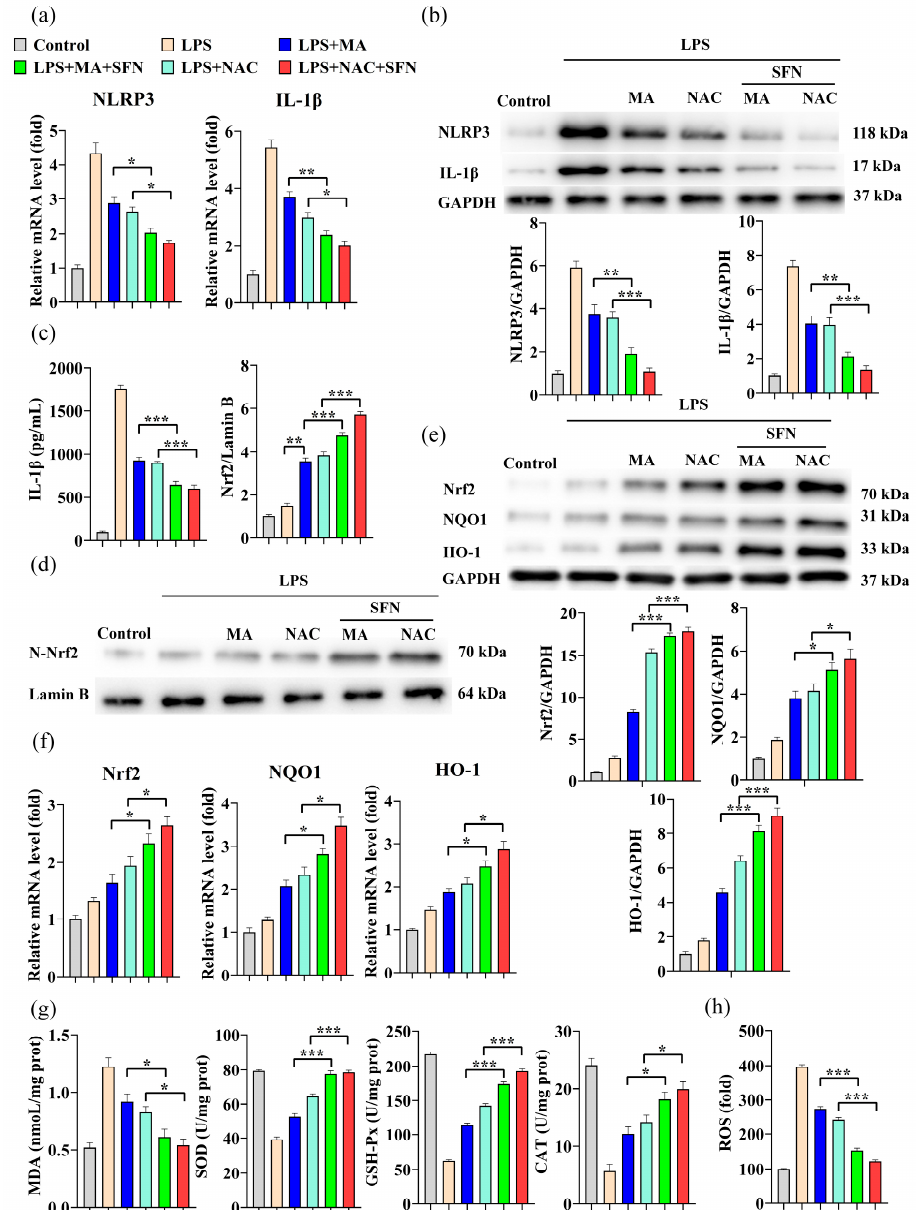
Figure 4. MA attenuates the inflammatory effects induced by LPS through the NLRP3/IL-1 β signaling pathway by activating the Nrf2 antioxidant pathway. Cells were pretreated with10 µ M SFN for 1 h and/or 100 mg/L MA for 12 h and/or 10 µ M NAC (Positive control) for 30 min and then stimulated with LPS (1mg/L) for 24h. ( a ) qRT-PCR was performed to evaluate the mRNA expression of NLRP3 and IL-1 β in RAW264.7 cells. ( b ) Western blot was performed to detect the protein levels of NLRP3 and IL-1 β in RAW264.7 cells. ( c ) ELISA was conducted to detect the levels of inflammatory cytokines IL-1 β in RAW264.7 cells. ( d ) Western blot was performed to detect the protein levels of N-Nrf2 (Nuclear-Nrf2) in RAW264.7 cells. ( e ) qRT-PCR was performed to evaluate the mRNA expression of Nrf2, NQO1 and HO-1 in RAW264.7 cells. ( f ) Western blot was performed to detect the protein levels of Nrf2, NQO1, and HO-1 in RAW264.7 cells. ( g ) MDA concentration was analyzed with 2-thiobarbituric and the activities of antioxidant enzymes including SOD, GSH-Px, and CAT were determined using ELISA kits. ( h ) The level of intracellular ROS was measured by DCF fluorescence using an enzyme marker. Data are shown as mean ± SEM obtained from three independent experiments. * p < 0.05, ** p < 0.01, *** p <